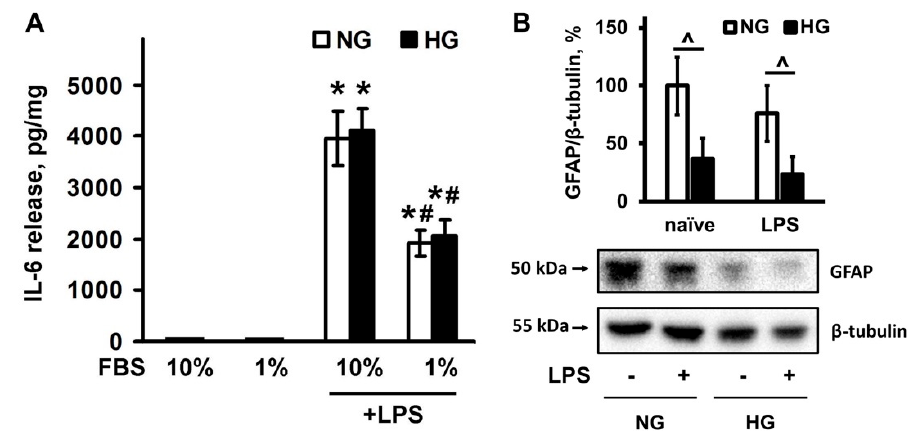
Figure 4. Dependence of GFAP expression and IL-6 release from serum concentration in the culture medium in LPS-stimulated cells, cultivated in normal (NG, 5 mM) or high (HG, 25 mM) glucose medium. ( A ) Primary rat astrocytes were cultivated in NG or HG medium with FBS concentration at 10% or 1%, and then stimulated with lipopolysaccharide (LPS, 100 ng/mL) for 4 h. IL-6 protein release was measured by ELISA in supernatant samples. The results are expressed as pg/mg. ( B ) primary rat astrocytes were cultivated in NG or HG medium with FBS concentration at 10%, and then stimulated with LPS, 100 ng/mL) for 4 h. Protein levels were evaluated by western blotting and normalized to the loading control β -tubulin. The values represent a mean ± SEM from three independent experiments. * p < 0.05, compared with the naive cells, # p < 0.05, compared with the LPS-stimulated cells with 10% FBS, ˆ p < 0.05 compared with the indicated bars. Abbreviations: GFAP-glial fibrillary acidic protein, FBS-bovine fetal serum, IL - interleukin.